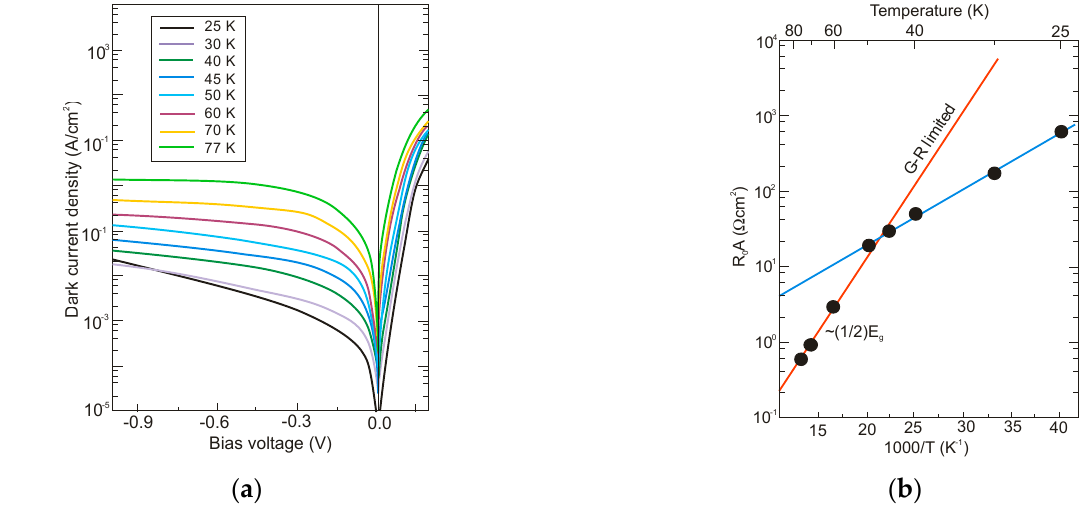
Figure 59. Dark electrical characteristics of LWIR InAs/InAsSb SL photodiodes: ( a ) current-voltage characteristics versus temperatures; ( b ) R o A versus temperature (after [164]).